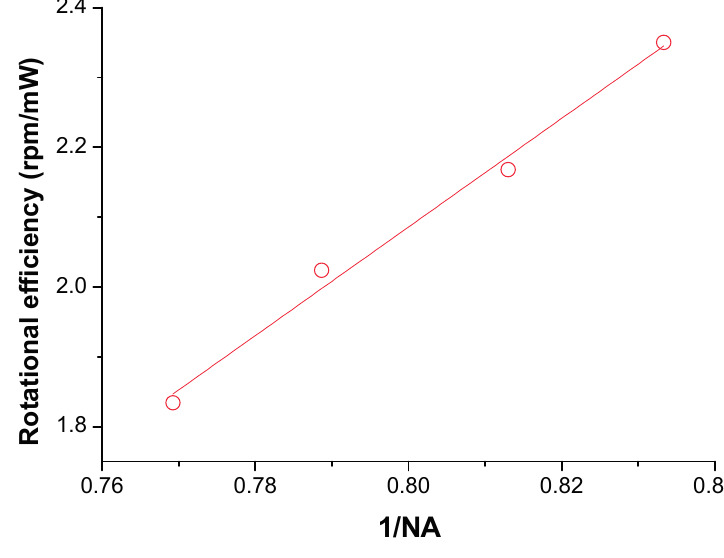
Figure 14. Rotational efficiency versus